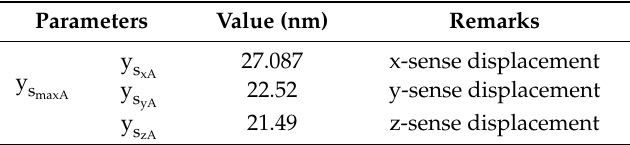
Analytically calculated sense displacements of the proposed single-drive, 3-axis MEMS gyroscope.